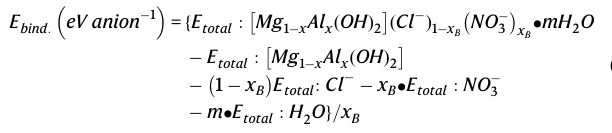
water along with chlorides emerges in the interlayer space of the optimised LDH structure e with highly charged LDHs and f with weakly charged LDHs, respectively. Here, the molecular arrangements are projected on the ab -plane of LDHs. In all crystal structures, orange, pale blue, red, white, green, and blue spheres represent magnesium, aluminium, oxygen, hydrogen, chlorine, and nitrogen atoms, respectively. To describe the interlayer hydrogen-bonding network, the interatomic bond lengths in the interlayer space (dotted lines) are set to 1.88 and 2.30Å as the maximum H – O and H – Cl bond lengths, respectively 50,51